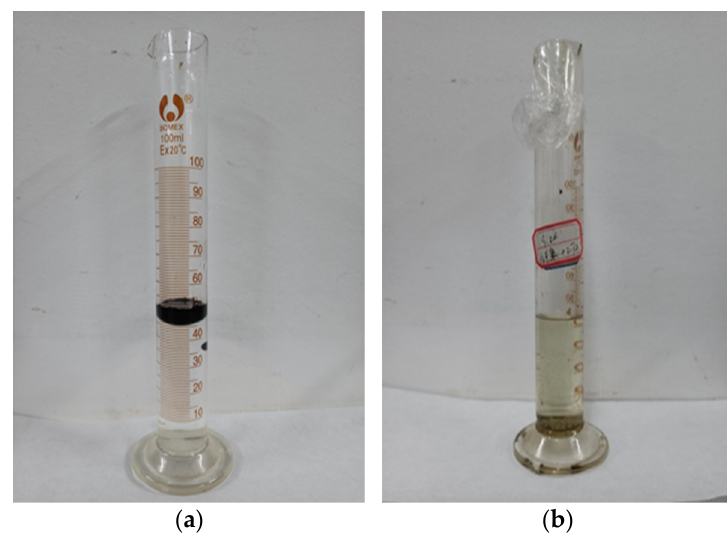
Figure A5. Diesel oil–water mixture ( a ) before reaction; ( b ) after reaction.